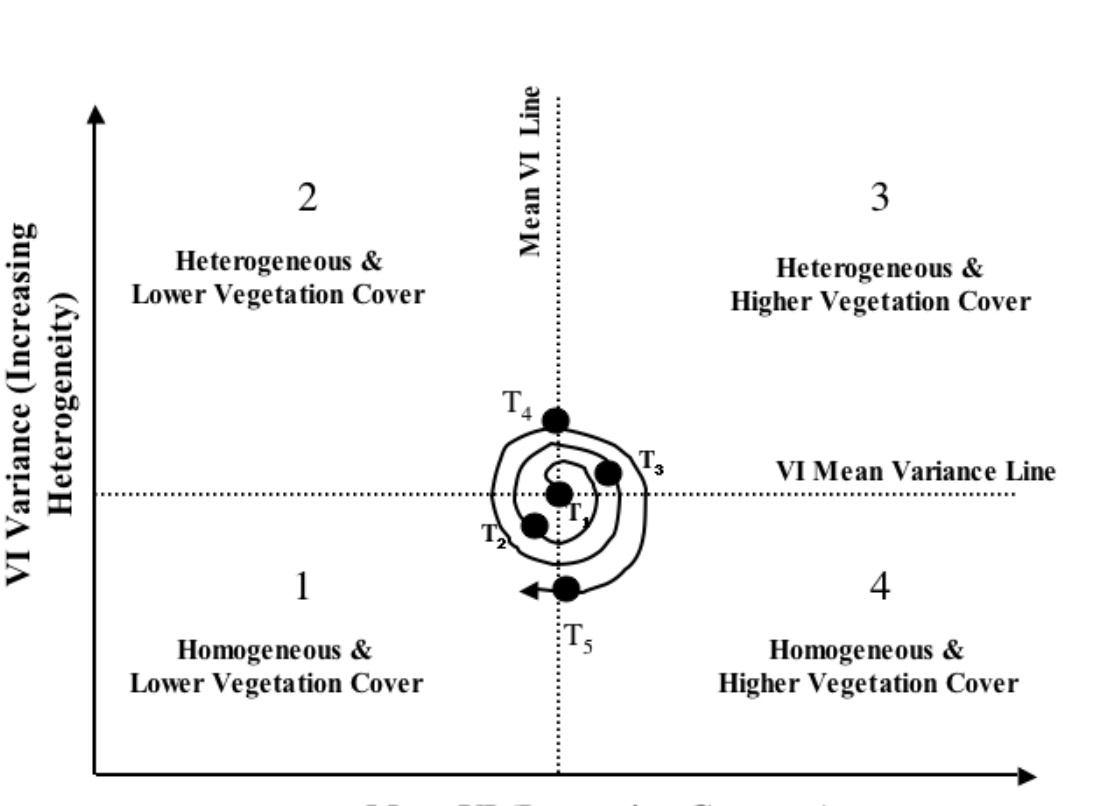
Fig. 2. Hypothetical statistical phase portrait of the interannual mean-variance dynamics of an agricultural landscape’s vegetation index (VI). T =